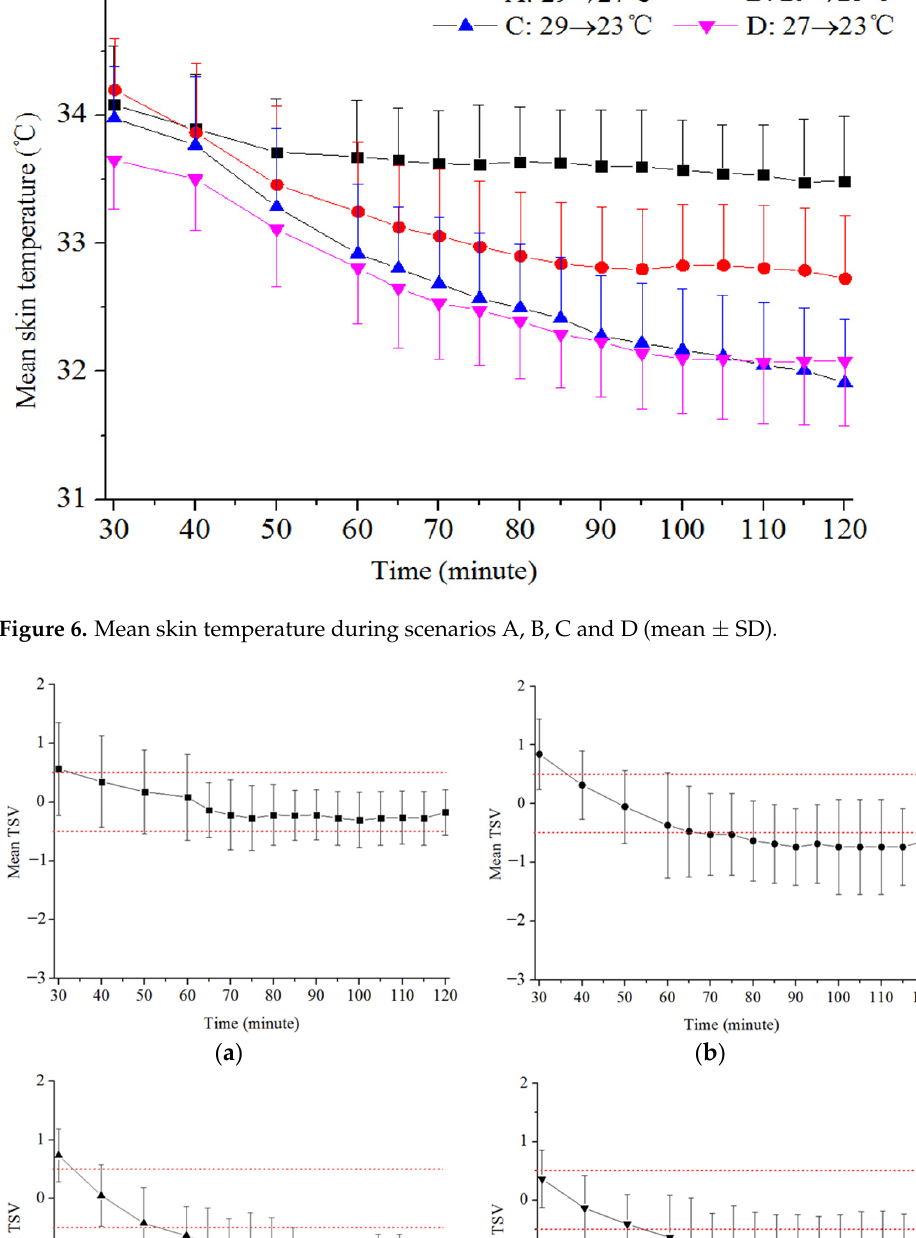
Figure 6. Mean skin temperature during scenarios A, B, C and D (mean ± SD).